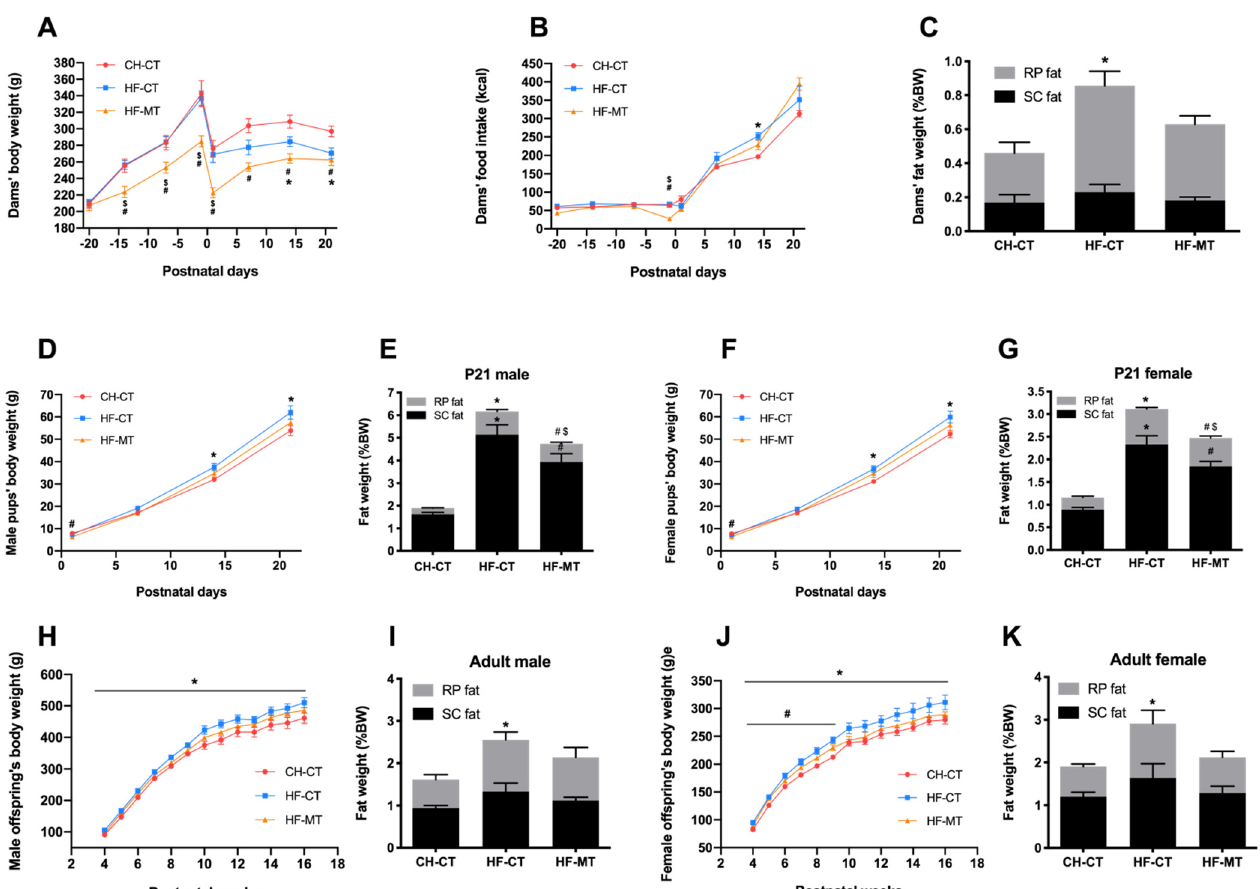
Figure 2. Maternal MT treatment improves HF − fed dams’ and offspring’s metabolic phenotype: ( A , B ) dams’ body weight and food intake during gestation and lactation; ( C ) dams’ subcutaneous (SC) and retroperitoneal (RP) fat weight (% body weight) at postnatal day 21; ( D , F ) body weight of male and female offspring during lactation; ( E , G ) male and female pups’ SC and RP fat weight (% body weight) at weaning; ( H , J ) body weight of male and female offspring from 4 to 16 weeks old; ( I , K ) male and female offspring’ SC and RP fat weight (% body weight) at 16 weeks of age. Data are presented as the mean ± SEM. CH ‐ CT, n = 8; HF ‐ CT, n = 8; HF ‐ MT, n = 7. Statistical analyses were performed using repeated ANOVA or one ‐ way ANOVA with Tukey’s post hoc tests. * p < 0.05, HF ‐ CT vs. CH ‐ CT; # p < 0.05, HF ‐ MT vs. CH ‐ CT; $ p < 0.05, HF ‐ MT vs. HF ‐ CT.